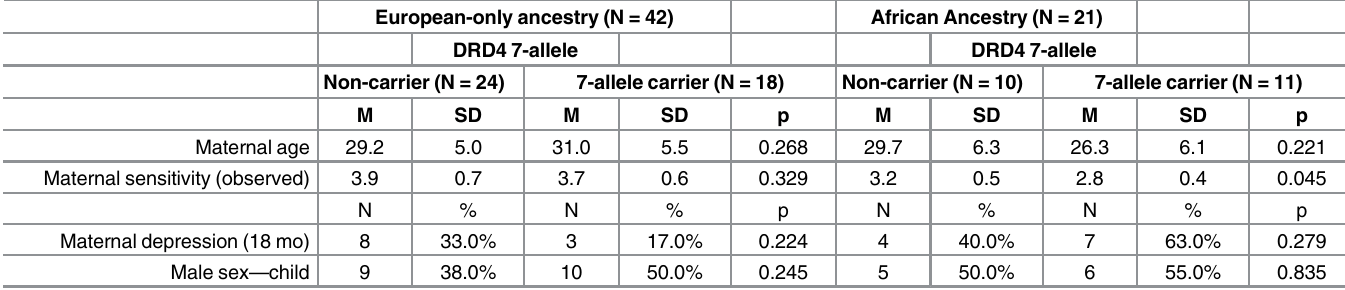
Table 1. Demographics of